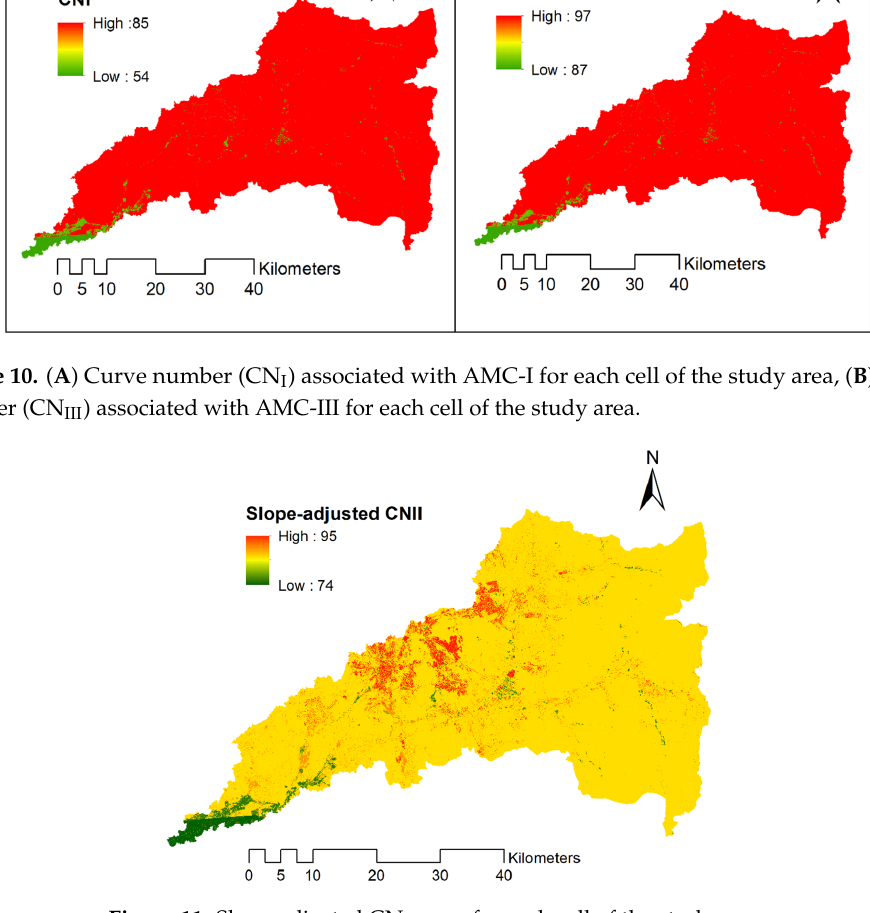
Figure 11. Slope-adjusted CN II map for each cell of the study area.